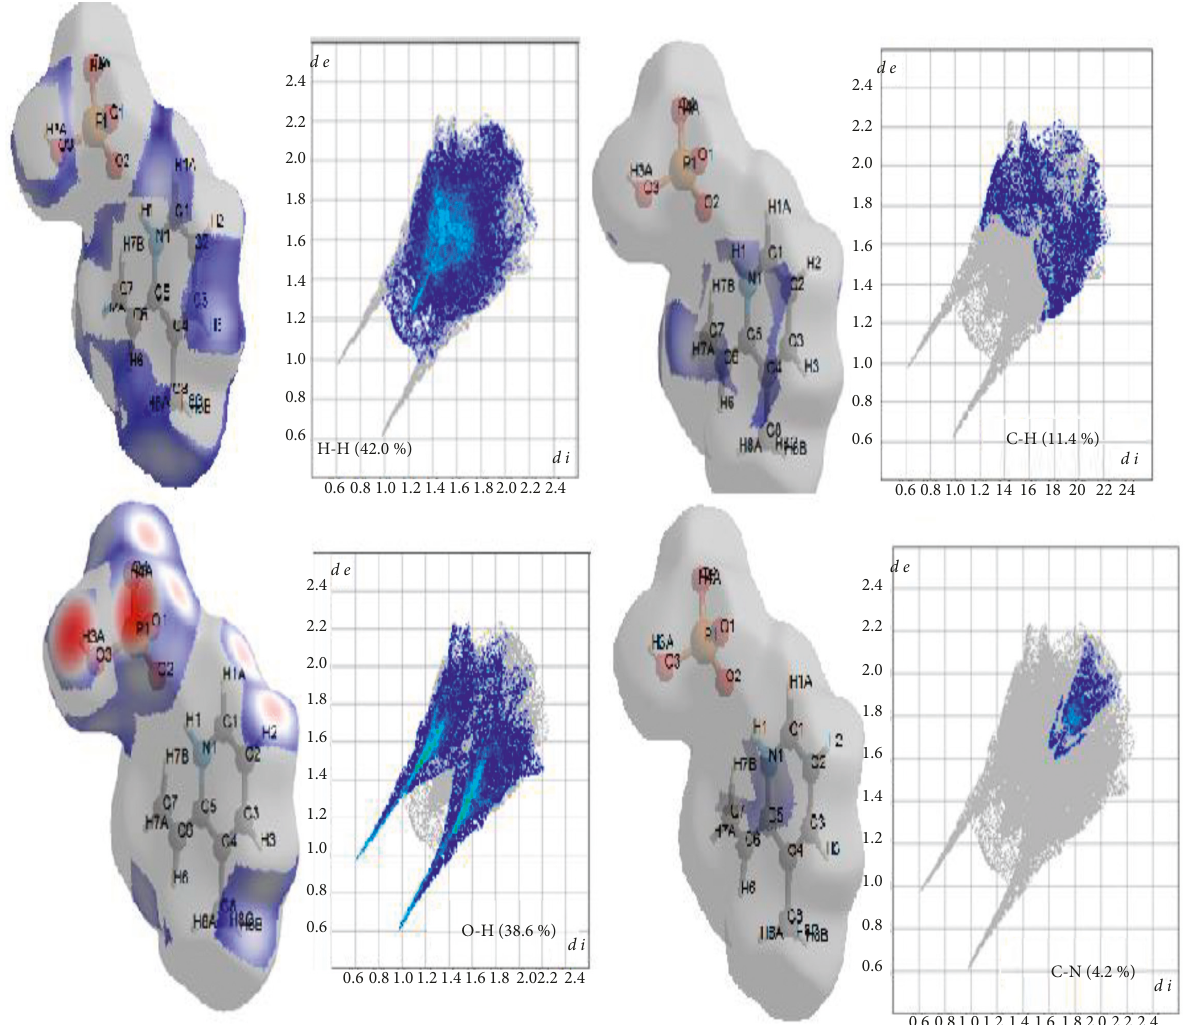
Figure 9: Relative contributions to the percentage of Hirshfeld surface area for the various intermolecular contacts in